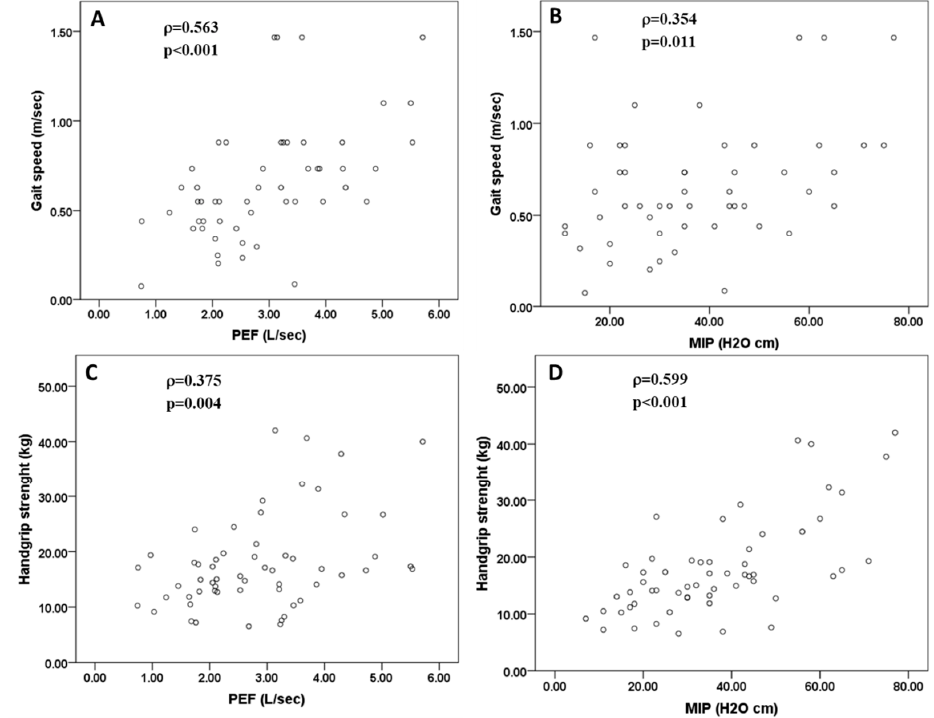
Figure 1. Representation of the significant correlations between skeletal and respiratory muscle sarcopenia parameters. Significant correlations between gait speed and PEF ( A ) or MIP ( B ) and between handgrip strength and PEF ( C ) or MIP ( D ).